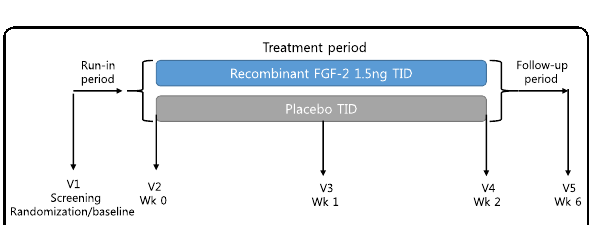
Fig. 7 Flowchart of the clinical pilot trial. V visit; Wk week